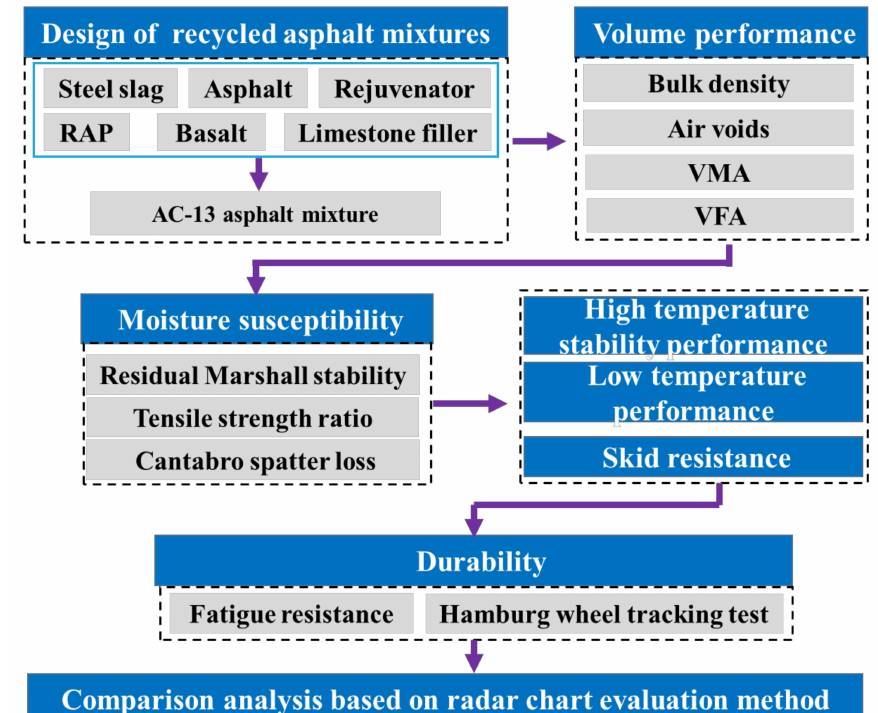
Figure 1. The experimental program of this